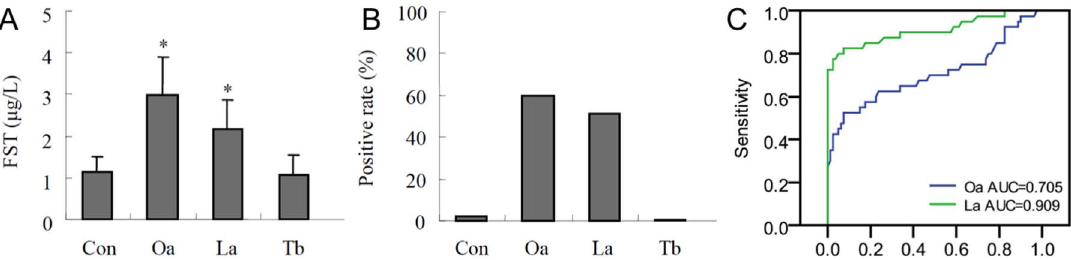
Figure 1. The levels of serum FST in health subjects and patients. (A) The serum FST levels were examined by ELISA. (B) The positive ratio of serum FST levels were represented in health subjects and patients using the 95th confidence interval in the healthy subjects as the cut-off value. Cont, health subjects control; Oa, ovarian mucinous adenocarcinoma; La, lung adenocarcinoma; Tb, tuberculosis. * P , 0.01, compared with health control group. (C) Receiver-operating characteristic (ROC) curve for FST for the diagnosis of lung adenocarcinoma and ovarian cancer. AUC: the area under the curve.